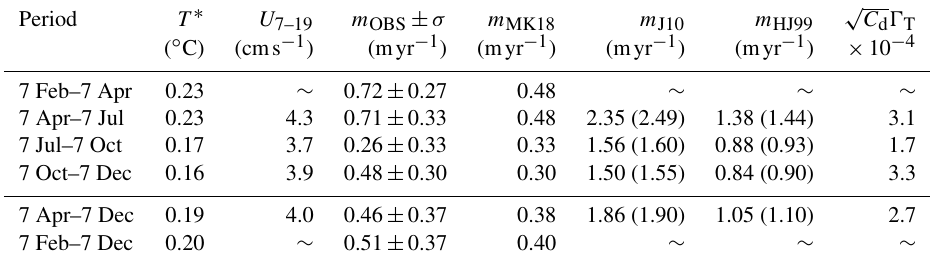
Table 3. Melt rates from observations and parameterisations. Columns 2–4 are average values observed over the periods given in column 1. Current speed U is depth-averaged over 7–19m below the ice base. To calculate m HJ99 a drag coefficient of C d = 0.0025 is used. The bracketed melt rate estimates show the effect of setting the heat flux into the ice shelf Q T √ C d (cid:48) T number